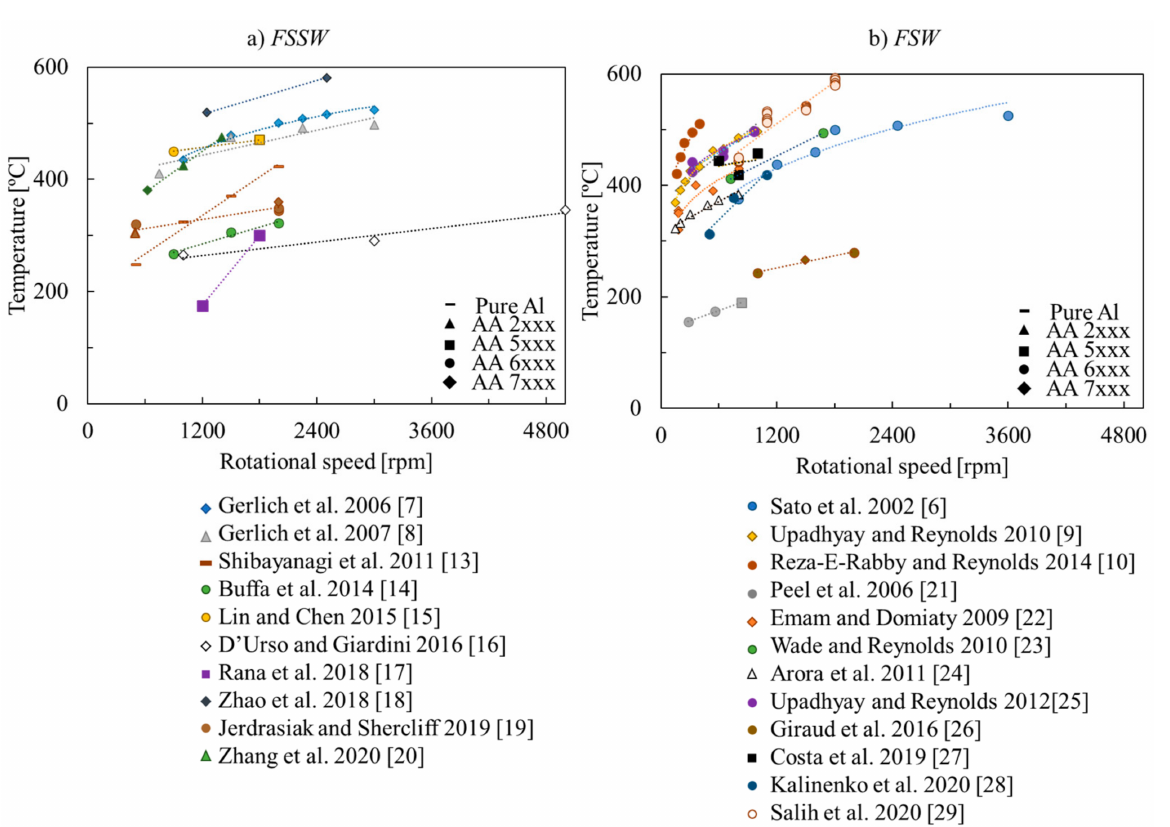
Figure 2. Evolution of the temperature with the rotational speed for the experimental works considered in Table 1 on